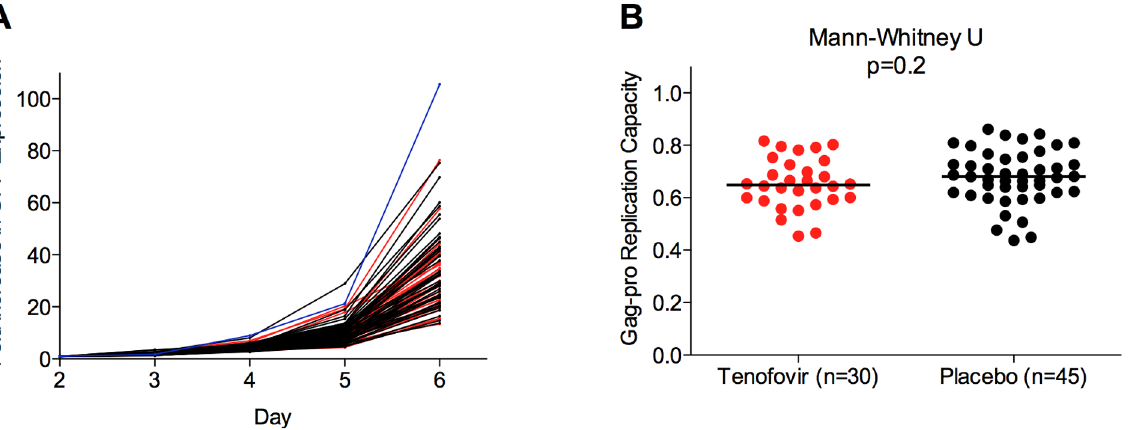
Figure 2. Replication capacity of recombinant viruses expressing Gag-Protease sequences from 1% tenofovir gel and placebo participants. Panel A: Replication data are shown for recombinant NL4-3 viruses encoding gag-protease from participants in the 1% tenofovir gel (red) and placebo (black) study arms, expressed as fold-increase in GFP expression over 6 days, relative to day 2. WT NL4-3 control is indicated in blue. Panel B: The replication capacities of recombinant viruses encoding participant-derived gag-protease sequences, calculated as the slope of viral spread normalised to WT NL4-3, are shown. No signifant difference in Gag-Protease function was observed between study arms (Mann-Whitney,